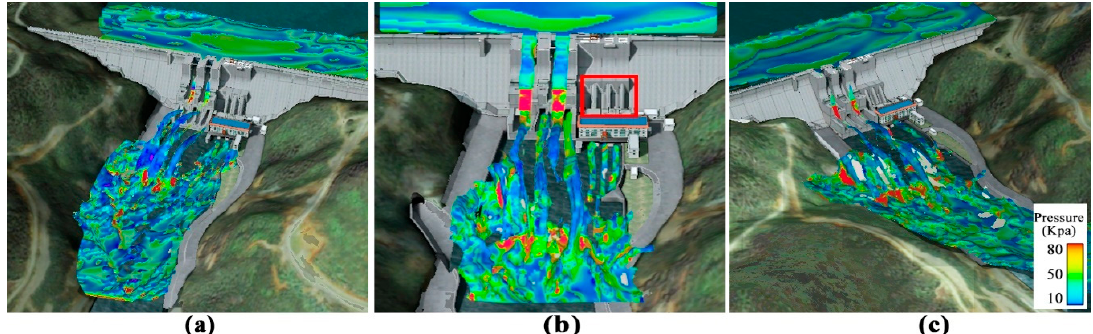
Figure 12. Partially enlarged view of local flow pattern under the normal water level. ( a ) local flow pattern from right-wing view; ( b ) local flow pattern from top view; ( c ) local flow pattern from left-wing view.